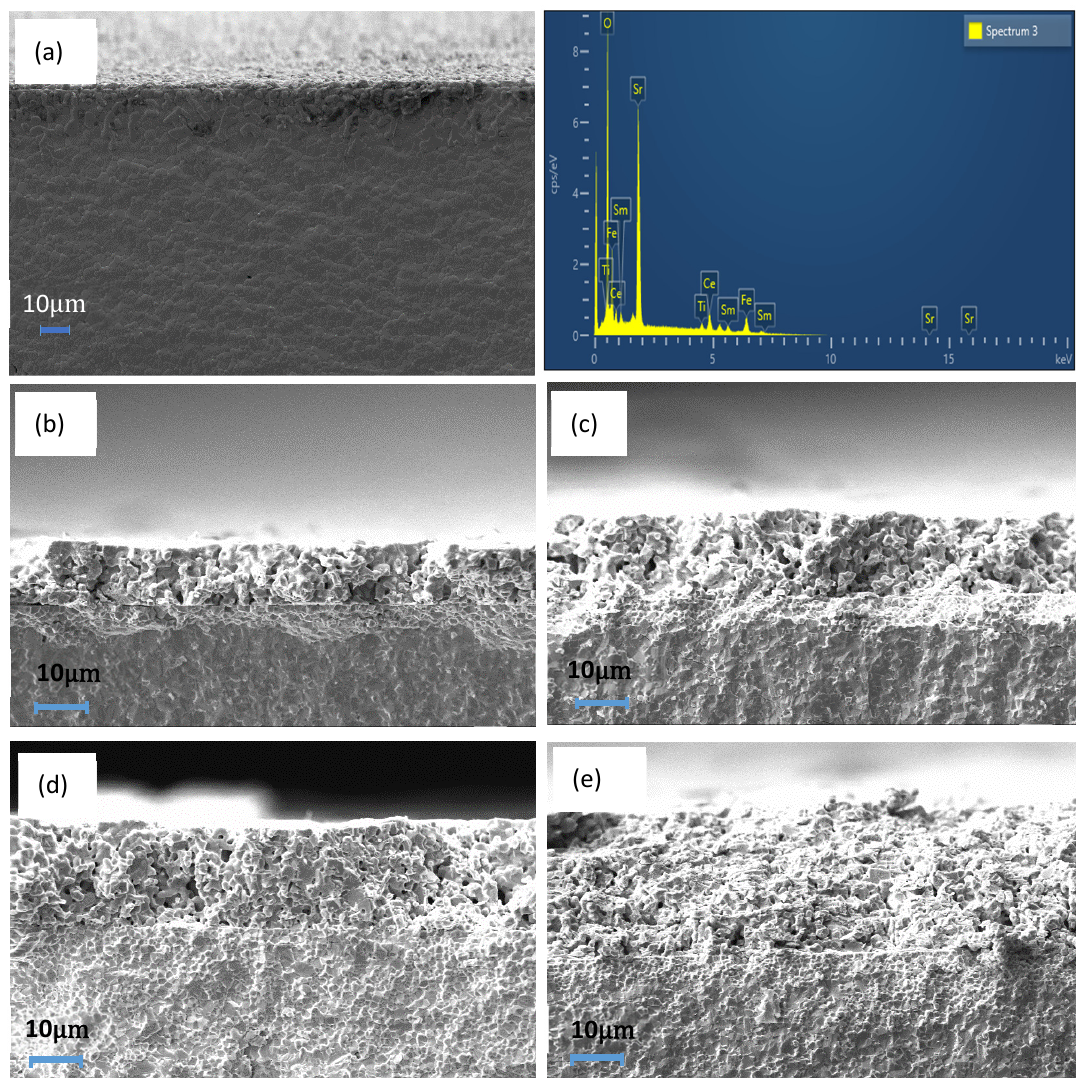
Figure 2. SEM images of the cross-section of ( a ) 1 × printing, ( b ) 3 × printing, ( c ) 5 × printing, ( d ) 7 × printing, and ( e ) 9 × printing. EDX image is for powder 9SFT-1SDC.